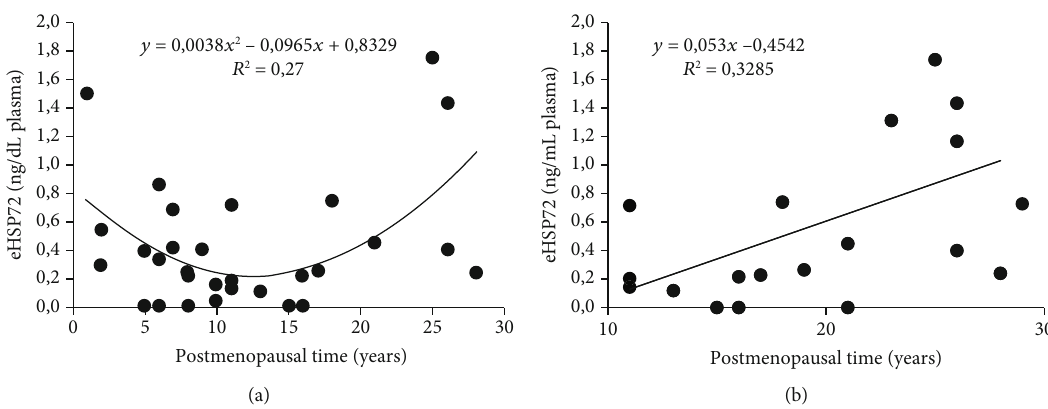
Figure 2: (a) Relation between eHSP72 levels and time of menopause. Positive correlation, linearized by quadratic regression ( n = 36 ; p = 0 : 0045 ). (b) Relation between eHSP72 and the time of menopause in women 12 to 29 years postmenopause. Linear and simple regression, positive correlation ( n = 17 ; p = 0 : 0248 ).